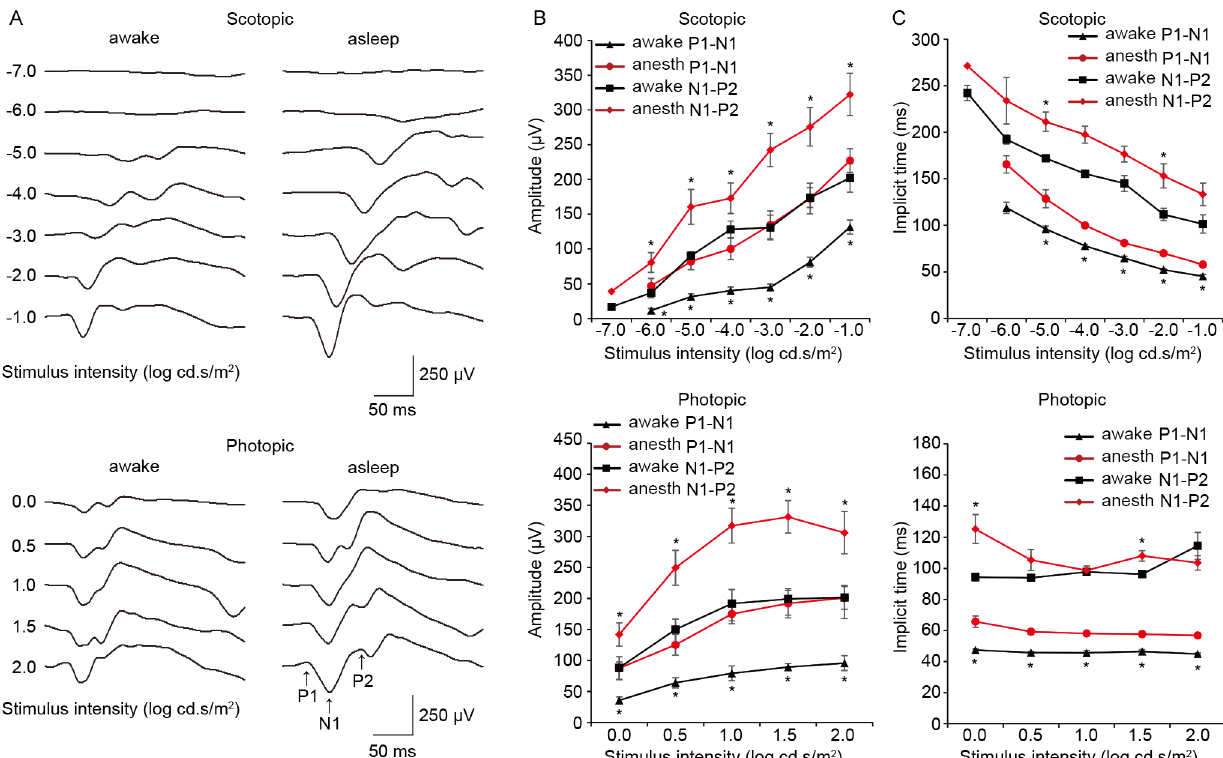
Fig 4. Comparison of VEPs recorded under awake and anesthetized conditions in the same mice. Representative traces of scotopic (top) and photopic (bottom) VEPs from the same mouse recorded in the awake (left) and anesthetized (right) condition. Amplitudes of scotopic (top) and photopic (bottom) VEPs from the same mice recorded in the awake (black) and anesthetized (red) condition. Implicit times of scotopic (top) and photopic (bottom) ERGs from the same mice recorded in the awake (black) and anesthetized (red) condition. * P < 0.05. Data from seven mice. The bars indicate mean ± S.E.M. anes: anesthetized.